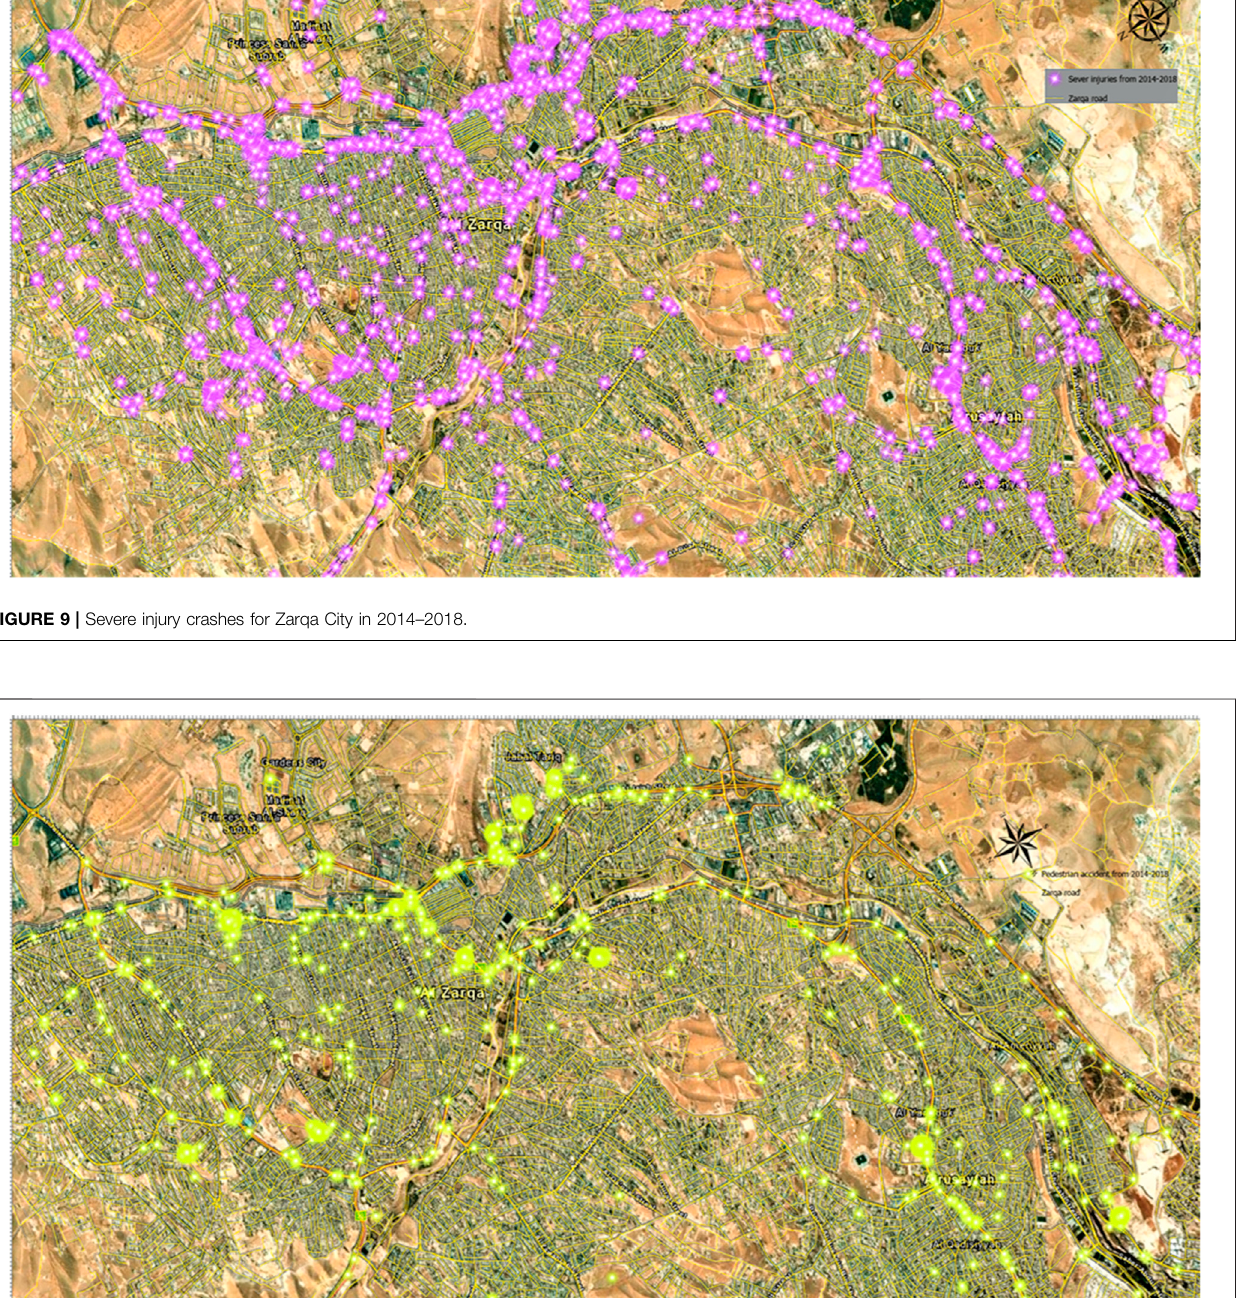
each crash location. Table 9 shows the descriptive statistics of